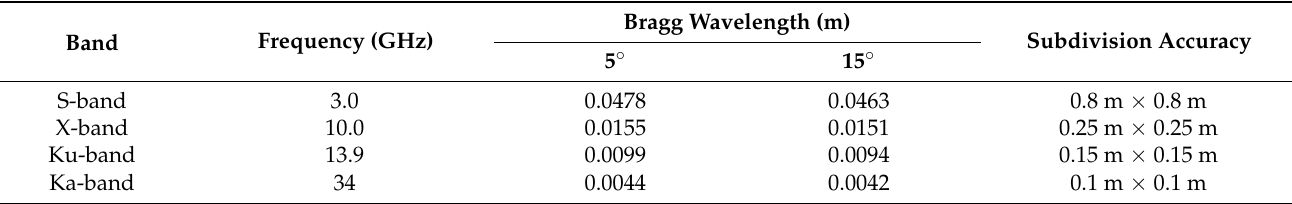
Table 2. Sea surface subdivision accuracy for different radar